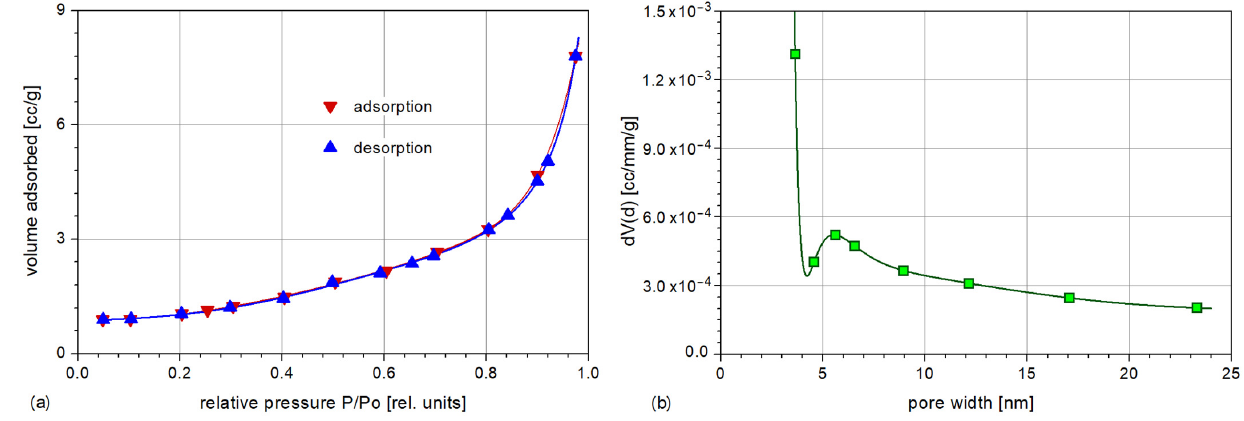
Figure 4. ( a ) The nitrogen adsorption–desorption isotherm of the magnetite sample and ( b ) pore size